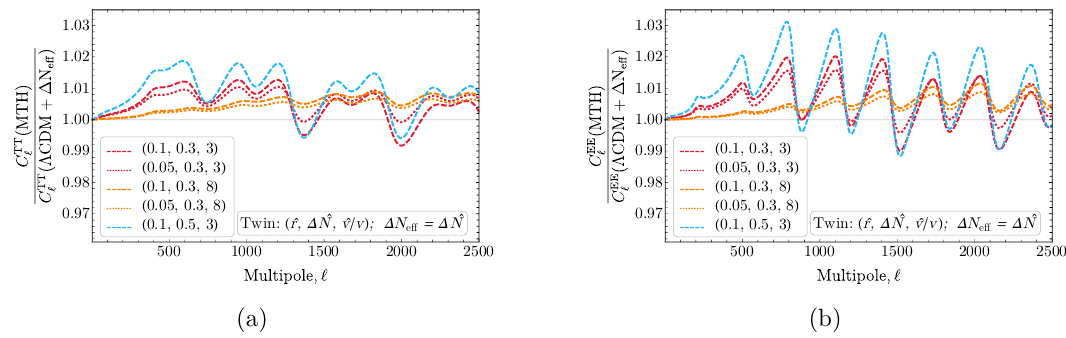
Figure 7. The ratio between the MTH model and the Λ CDM+ ∆ N eff model of the CMB temperature (figure 7(a)) and polarization (figure 7(b)) power spectra.